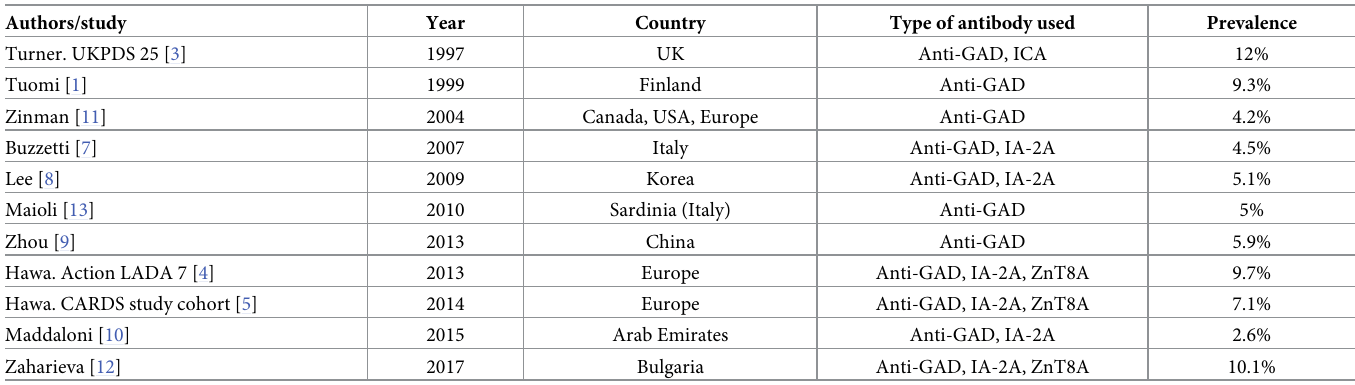
Table 1. LADA prevalence in different